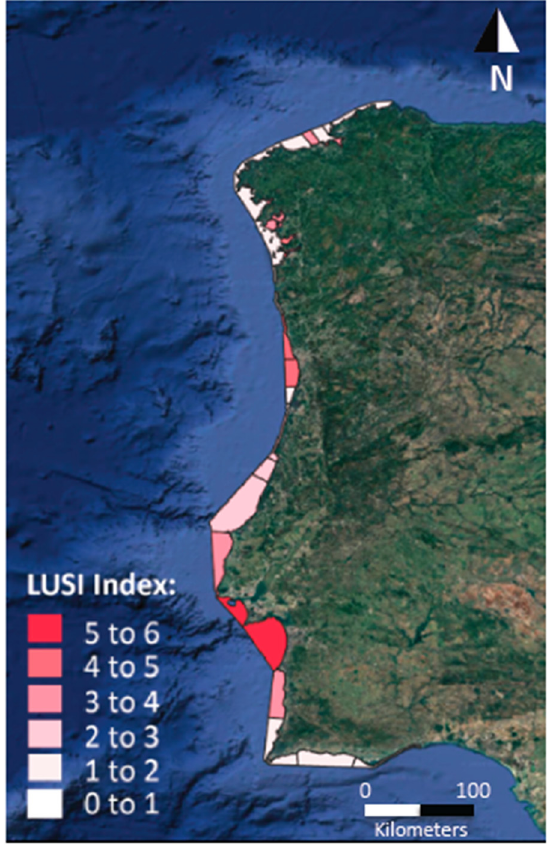
Figure 8. LUSI index values for the different coastal water bodies. Light red represent low LUSI and dark red represent high LUSI values. Please note the values and dark red represent high LUSI values. Please note the colorbar.